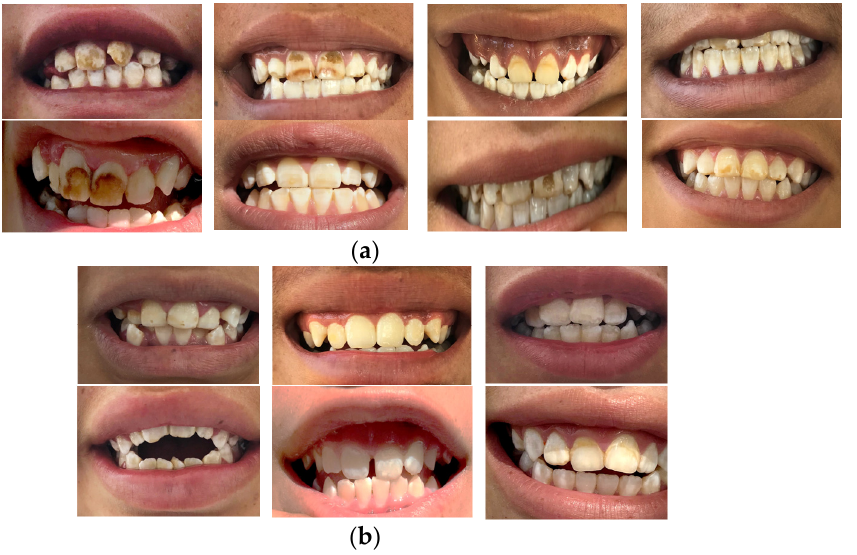
Figure 4. Front teeth of participants who presented high concentrations of F − and urinary As at baseline (week 0) of the investigation. ( a ) Boys; ( b ) girls. The boys and girls who presented high contents of the biomarkers frequently consumed tap water for drinking and food preparation.